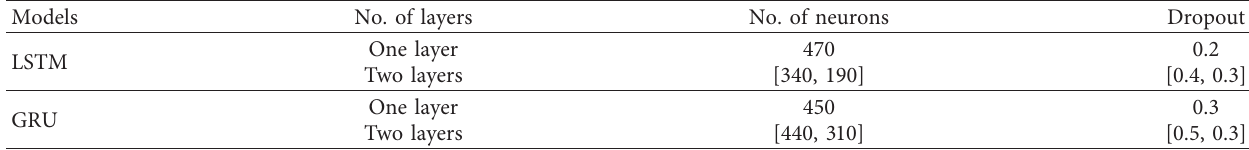
Table 12: The best value parameters of DL for death cases in Kuwait.